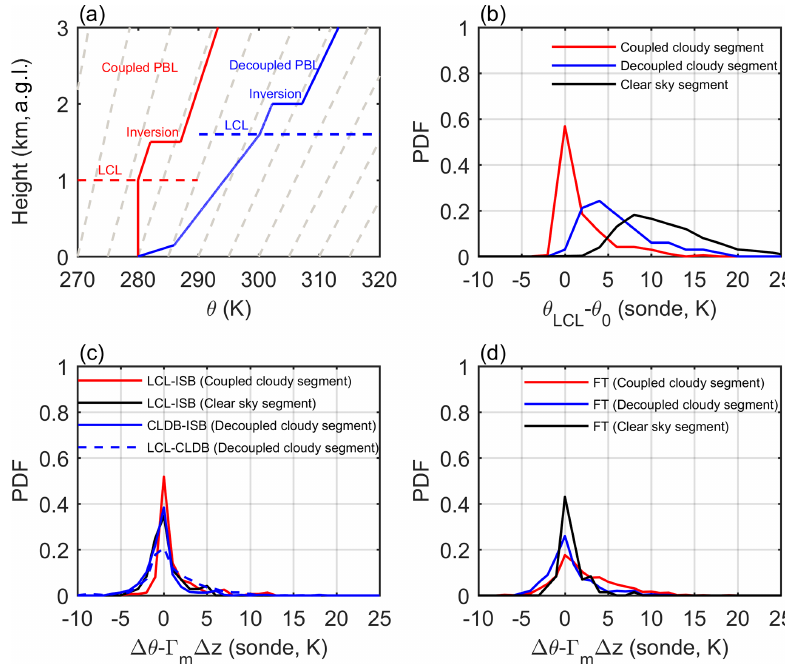
Figure 2. Illustrations of PBL θ profiles (a) , with the LCL heights indicated by dashed horizontal lines and the moist adiabat represented by light dashed lines. PDFs of the θ difference between the LCL and 150ma.g.l. (b) , the θ difference with the moist adiabat removed between the LCL and the inversion base (c) , and the θ difference with the moist adiabat removed for the free troposphere between the inversion top and 3kma.g.l. (d) . The red, blue and black lines are for coupled cloudy, decoupled cloudy and clear-sky segments, respectively. In (c) , the θ differences of decoupled cloudy segments are further separated into those between the LCL and the cloud base (dashed blue line) and those between the cloud base and the inversion base (solid blue